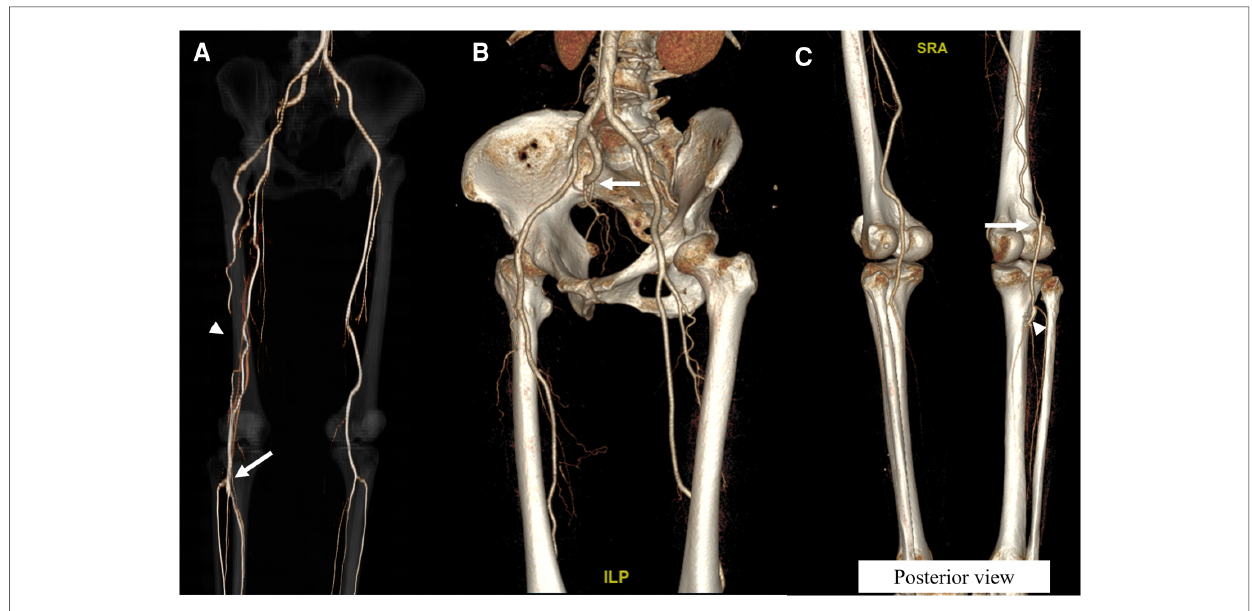
FIGURE 2 Follow-up computed tomography angiography (CTA) images of the fi rst case. ( A ) Following the operation, a three-dimensional reconstruction image 1 month after the operation demonstrated a well patent distal popliteal artery ( arrow ) and preserved fl ow from the collaterals from the deep femoral artery ( arrowhead ). ( B ) CTA 3 years after the operation revealed the complete occlusion of the persistent sciatic artery from the buttock ( arrow ). ( C ) Posterior view of the CTA 3 years after the operation demonstrated well patent collaterals from the deep femoral artery ( arrow ) and patent operation site ( arrowhead